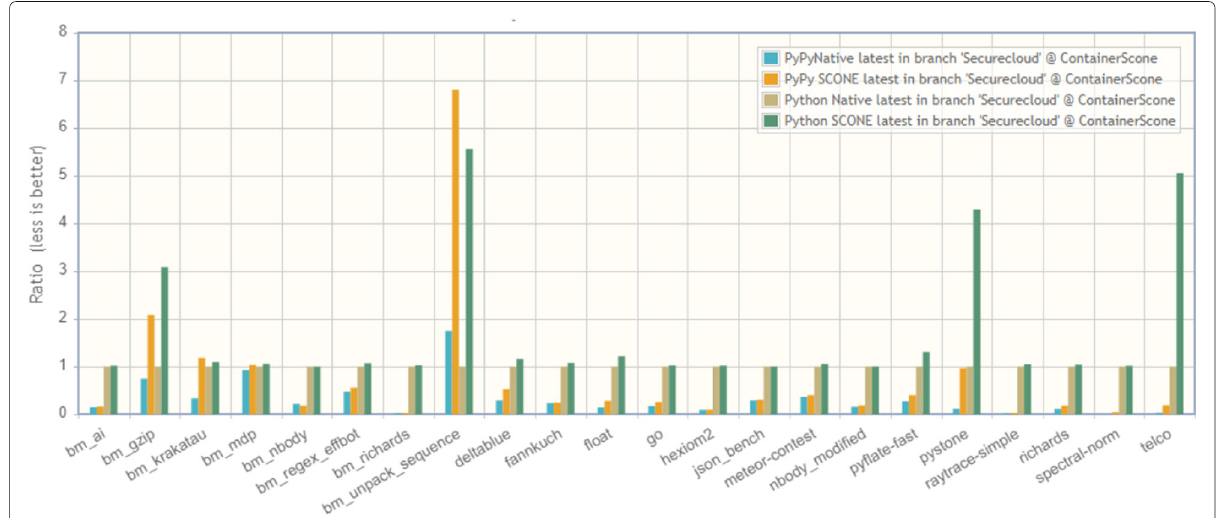
Fig. 3 Performance overhead of common Python benchmarks running with SCONE